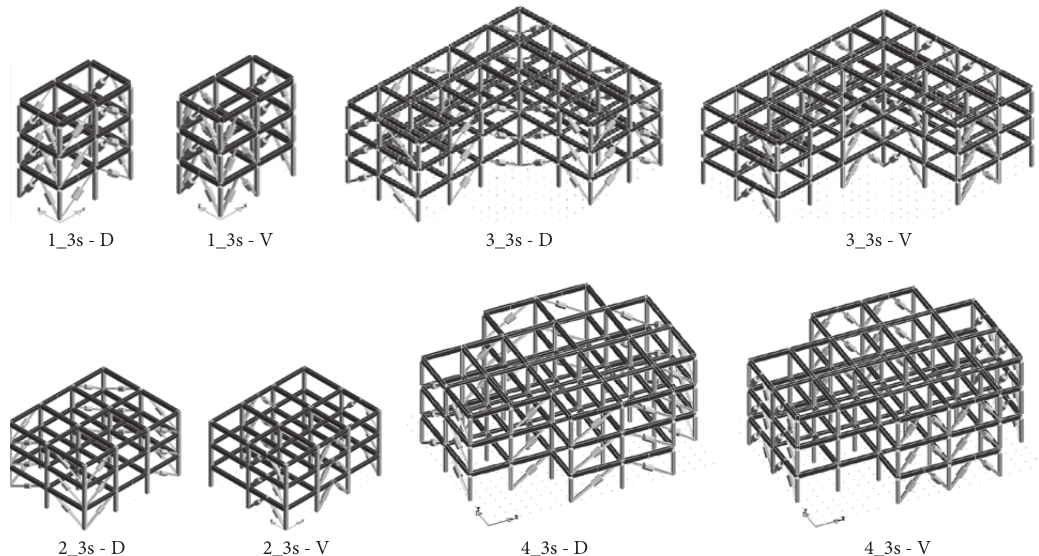
Figure 11: Numerical models of different 3 storey structures braced with different configurations of EDBs (V and